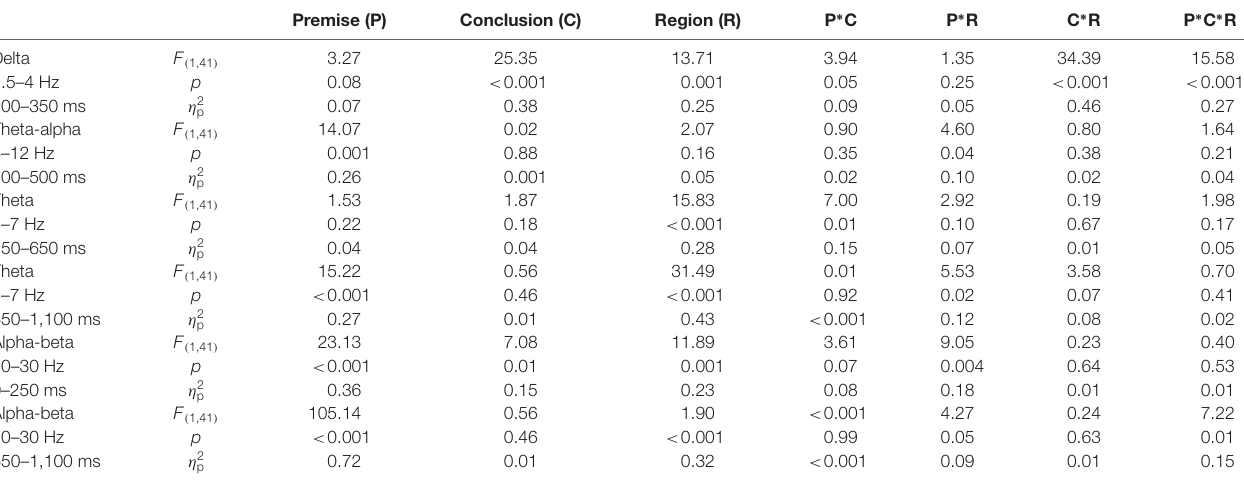
TABLE 2 | Results of the three-way repeated-measures ANOVAs of phase-locked and non-phase-locked power. Premise (P) Conclusion (C) Region (R) P ∗ C P ∗ R C ∗